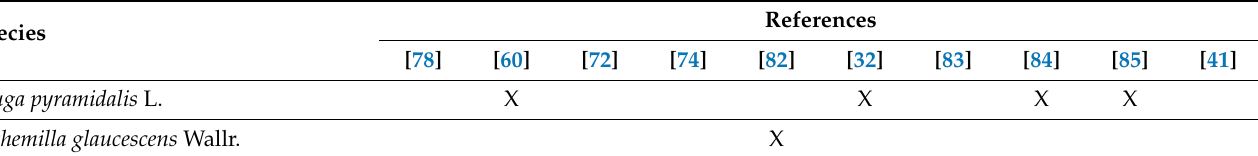
Table 1. Grassland plants for which there is evidence that they occur as legacies of historical land use in boreo-nemoral forests (Marked with X). The category “grassland plants” was based on [77]. For species marked with * the categorization has been questioned [82,84,85]. “Reference” is according to the number in the reference